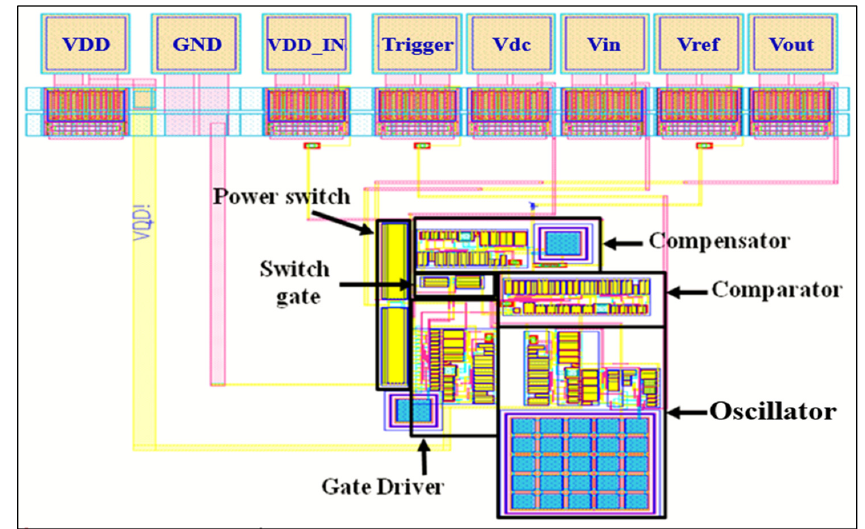
Figure 10. Die photo of the DC–DC boost converter.